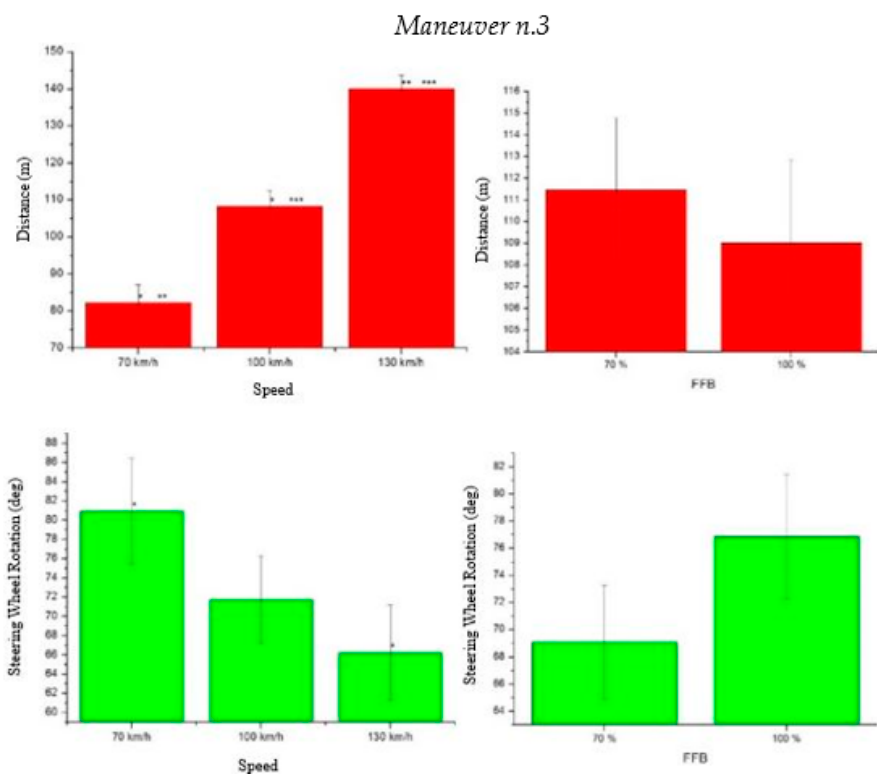
Figure 6. Speed and F.F.B. effect on steering wheel oscillation.